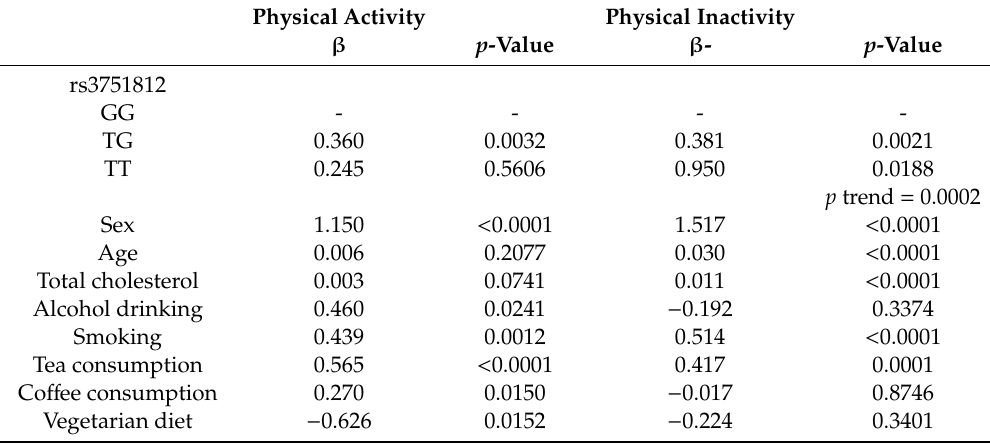
Table 5. Association between rs3751812 and obesity based on physical